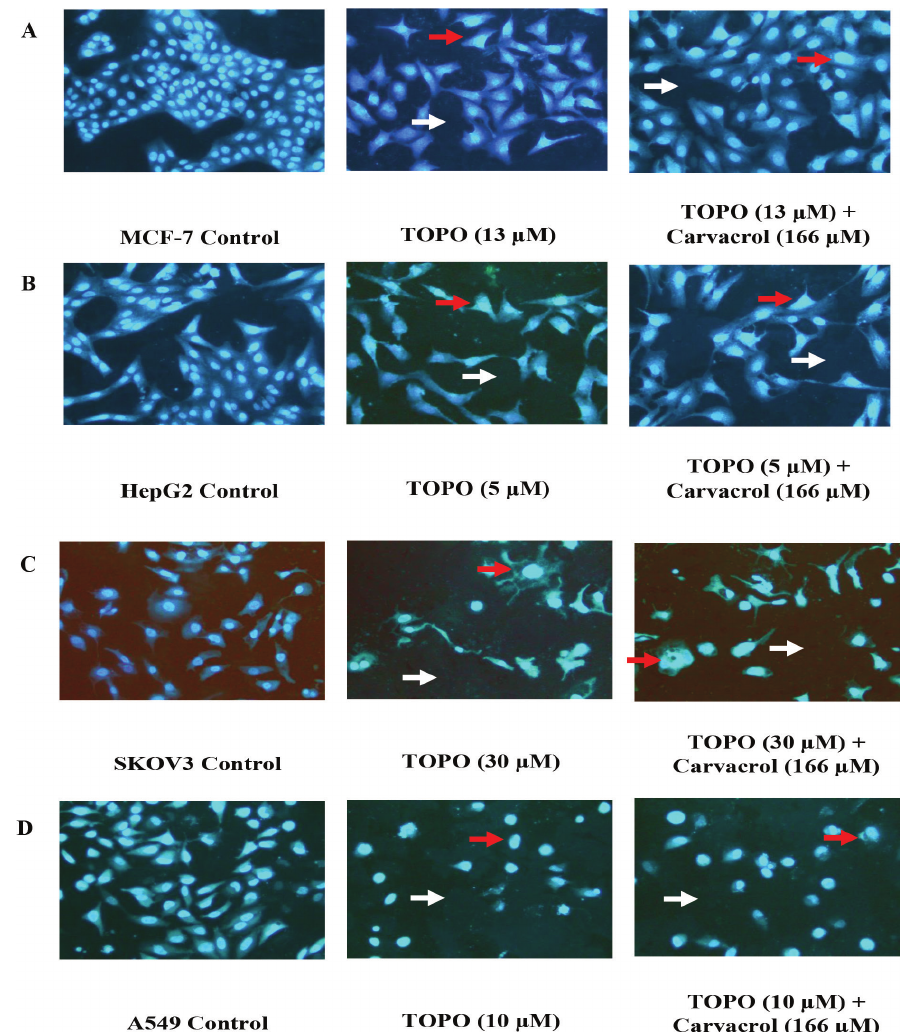
Figure 6. Fluorescent microscopy images (Scale bar: 20 µm) of (A) MCF-7, (B) HepG2, (C) SKOV3 and (D) A549 cell lines cell lines treated for 24 h with TOPO IC in the absence or presence of carvacrol (166 µM). Images were magnified at 20×. The red, and white arrows 50 represented nuclear enlargement or irregular shape, and intercellular space increase, respectively. Images were taken from at least three independent experiments with similar